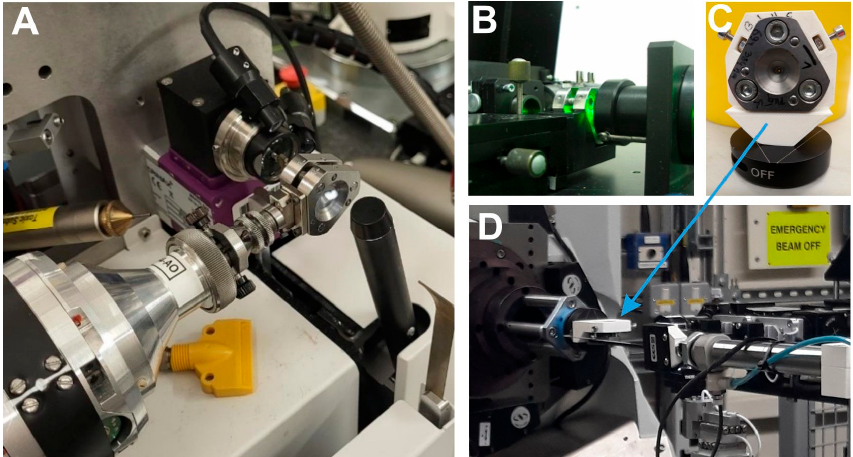
Figure 5. High pressure X-ray experiment: ( A ) mounting DAC with the use of goniometer head (ESRF, beamline ID30B, France); ( B ) determination of the pressure inside the DAC (green light of the laser is used to excite the ruby fluorescence and the proportional shift of line R1 694.25 nm determines the pressure inside the DAC); ( C ) the holder produced with 3D printer; ( D ) mounting DAC with the fi tt ed holder (DIAMOND, beamline I19, UK).